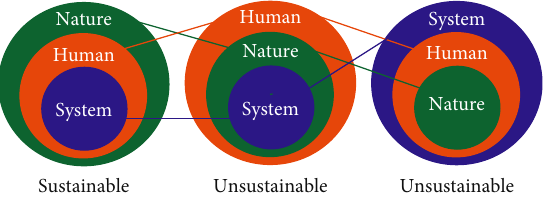
Figure 2: Models for human, structures, and nature (HNS): (a) sustainable and (b and c) unsustainable. Redrawn from this source